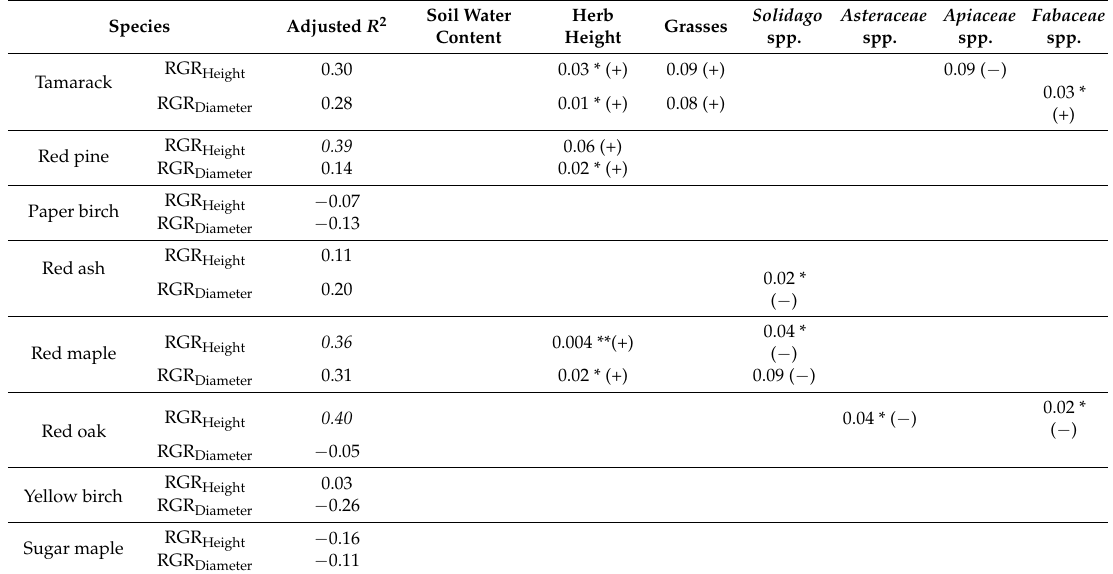
Table 5. Results of multiple regressions of height and diameter relative growth rates (RGR) (fall 2010–fall 2012) in relation to soil water content, average herb height, percentage cover of grasses, Solidago , Asteraceae , Apiaceae , and Fabaceae (legumes) species. Species Adjusted R 2